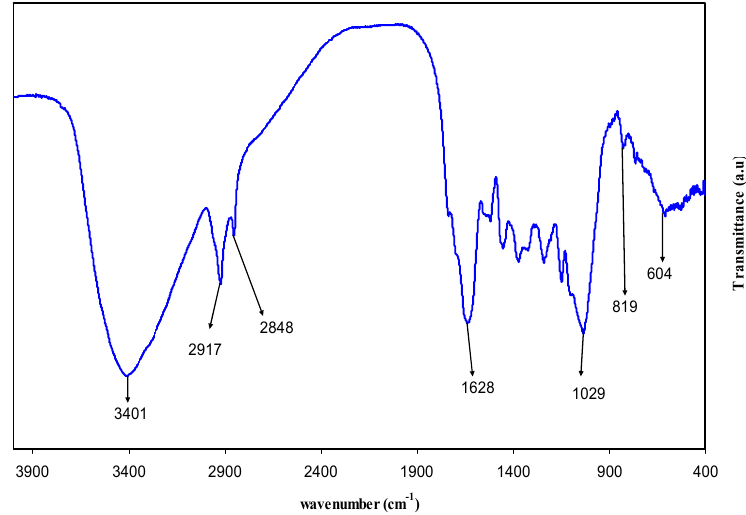
Figure 2. Fourier transform infrared (FTIR) spectra of pure green tea (GT) extract.